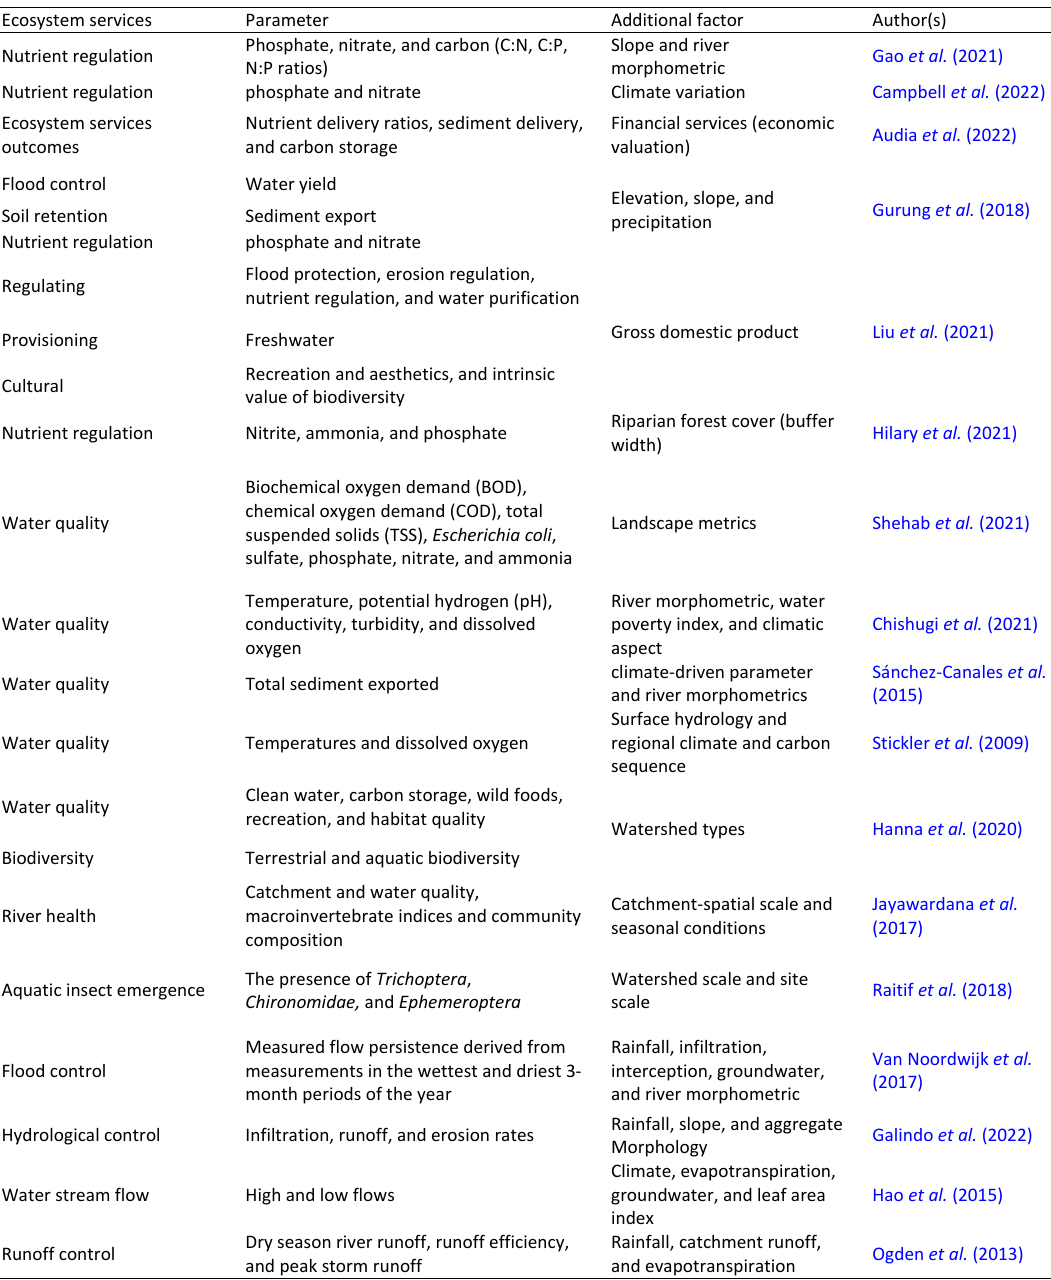
Table 3: RES parameter and its additional factors